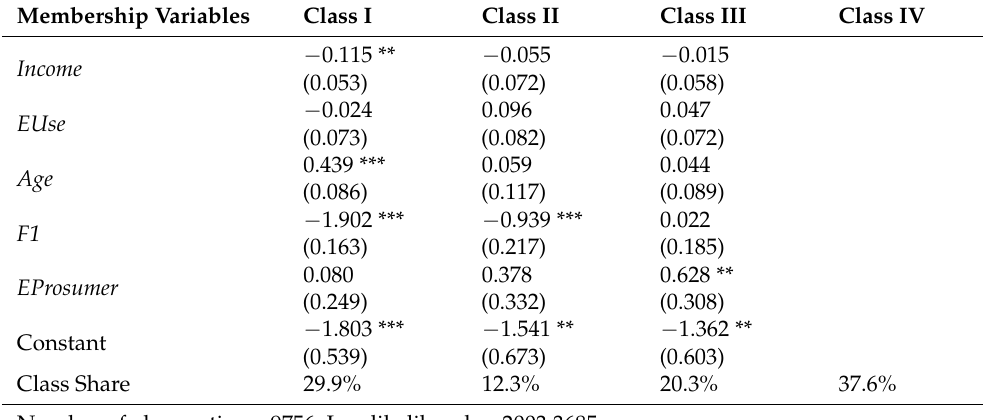
Table 7. Latent Class